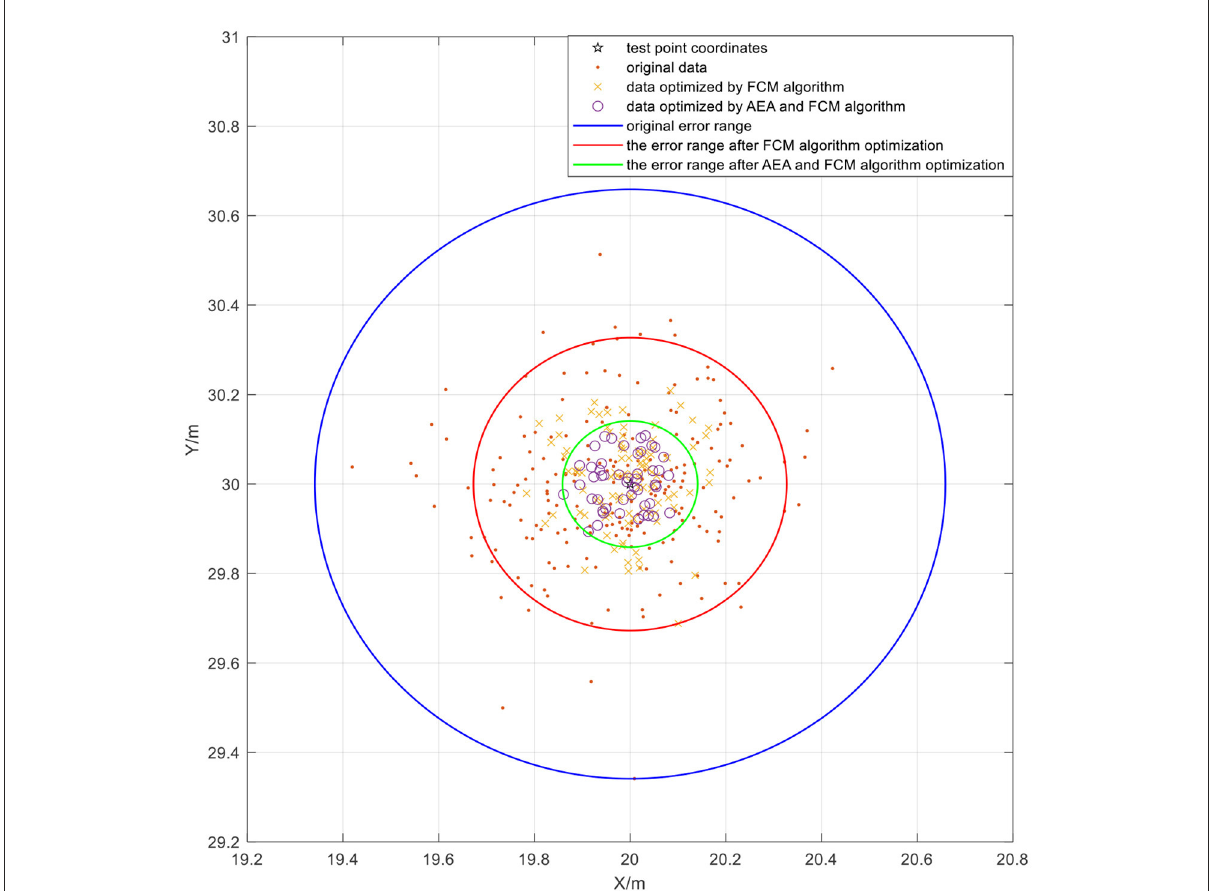
FIGURE18 Comparison of positioning effects under application of the two algorithms.